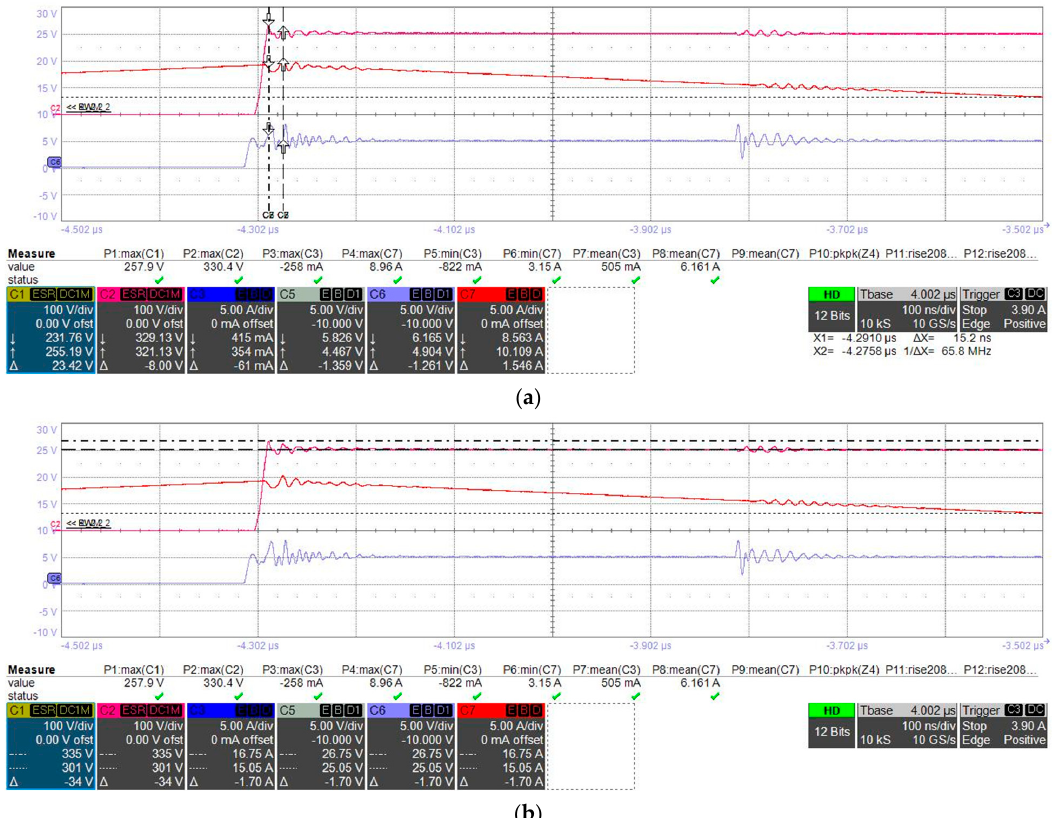
Figure 26. V DS measurements (yellow and purple traces are, respectively, the V DS of the two power devices, red and blue traces are the inductors currents, grey and light blue traces represent the two driving PWM signals): ( a ) ringing frequency at turn-off; ( b ) overshoot amplitude at turn-off. The efficiency plot, in Figure 27, shows how at low load the switching losses play an important role and cause a drop in efficiency. As the output load increases, their influence becomes less graving while conduction losses are limited thanks to the low R DS(on) of the two switches, allowing them to reach a peak efficiency of around 98%. Figure 27. Efficiency plot vs. output power. 9091 9293949596 9798 99100 90